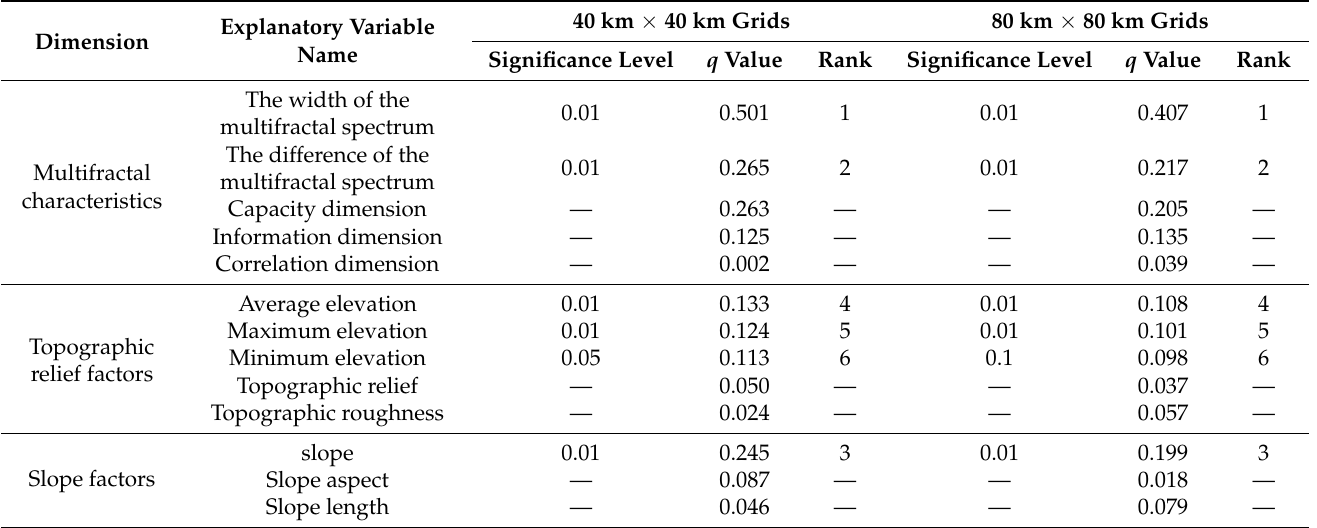
Table 3. The results of geographical